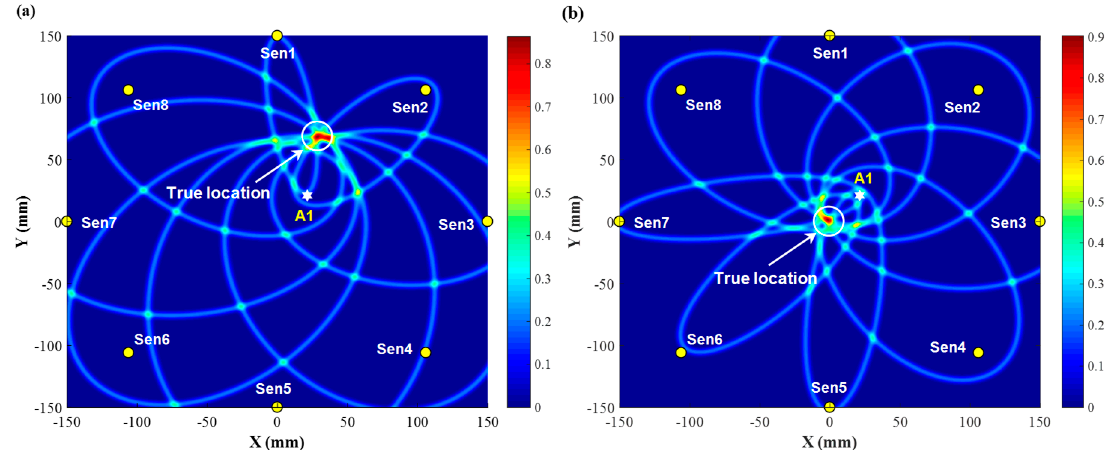
Figure 11. Diagnostic image obtained using the ToF-based PDI algorithm: ( a ) damage at (30 mm, 70 mm); ( b ) damage at (0, 0).